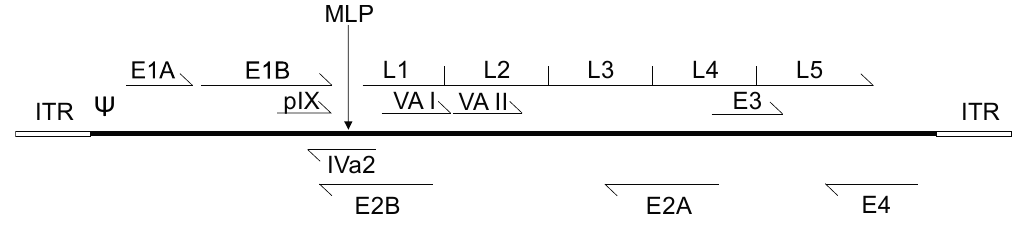
Figure 1. Schematic representation of the adenovirus genome. The inverted terminal repeat (ITR) sequences act as origins of viral replication, while Ψ represents the adenoviral packaging sequence. Adenovirus early transcripts (E1–E4) are transcribed upon viral entry, and expression of the intermediate transcripts pIX, IVa2, VA I and VA II follows. Activation of the major late promoter (MLP) occurs after the onset of adenovirus DNA replication, and generates a single transcript from which late transcription units, L1 ‐ L5, are spliced.